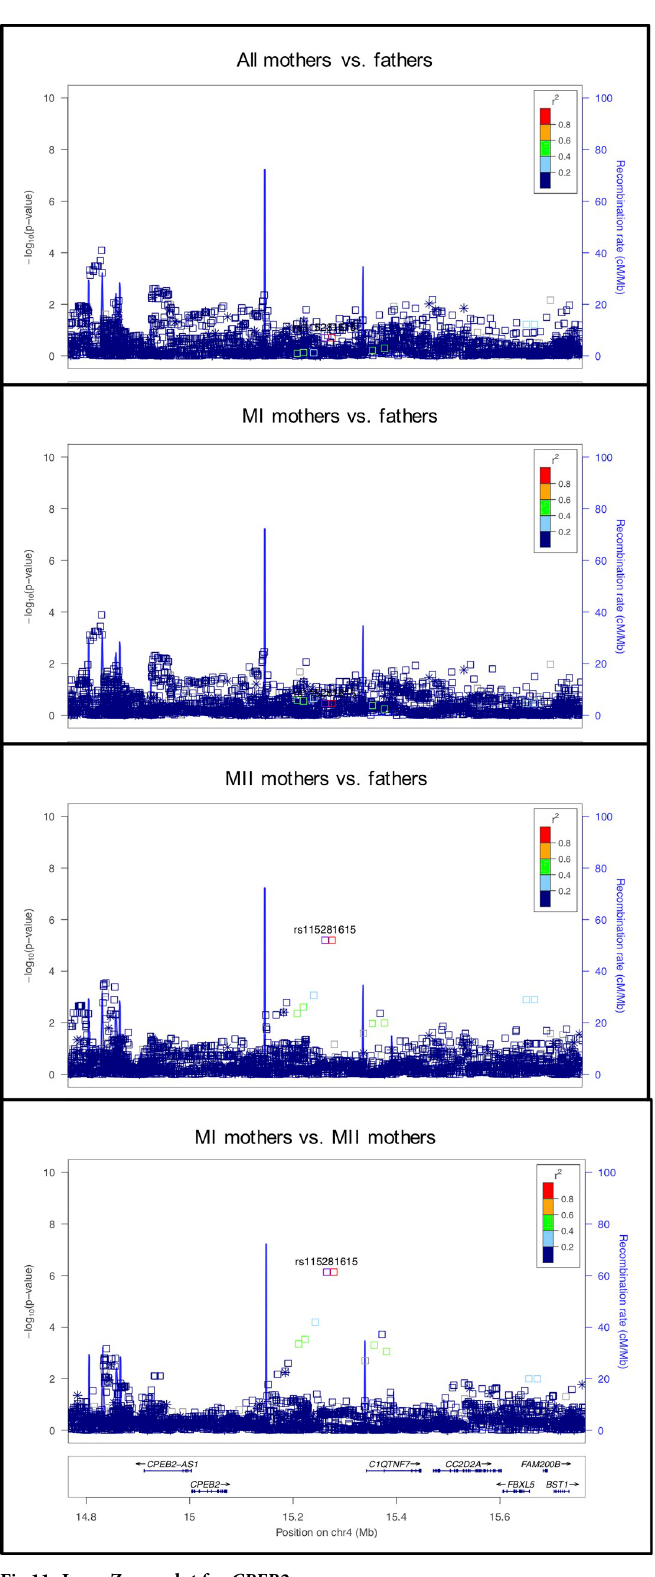
Fig 11. LocusZoom plot for CPEB2